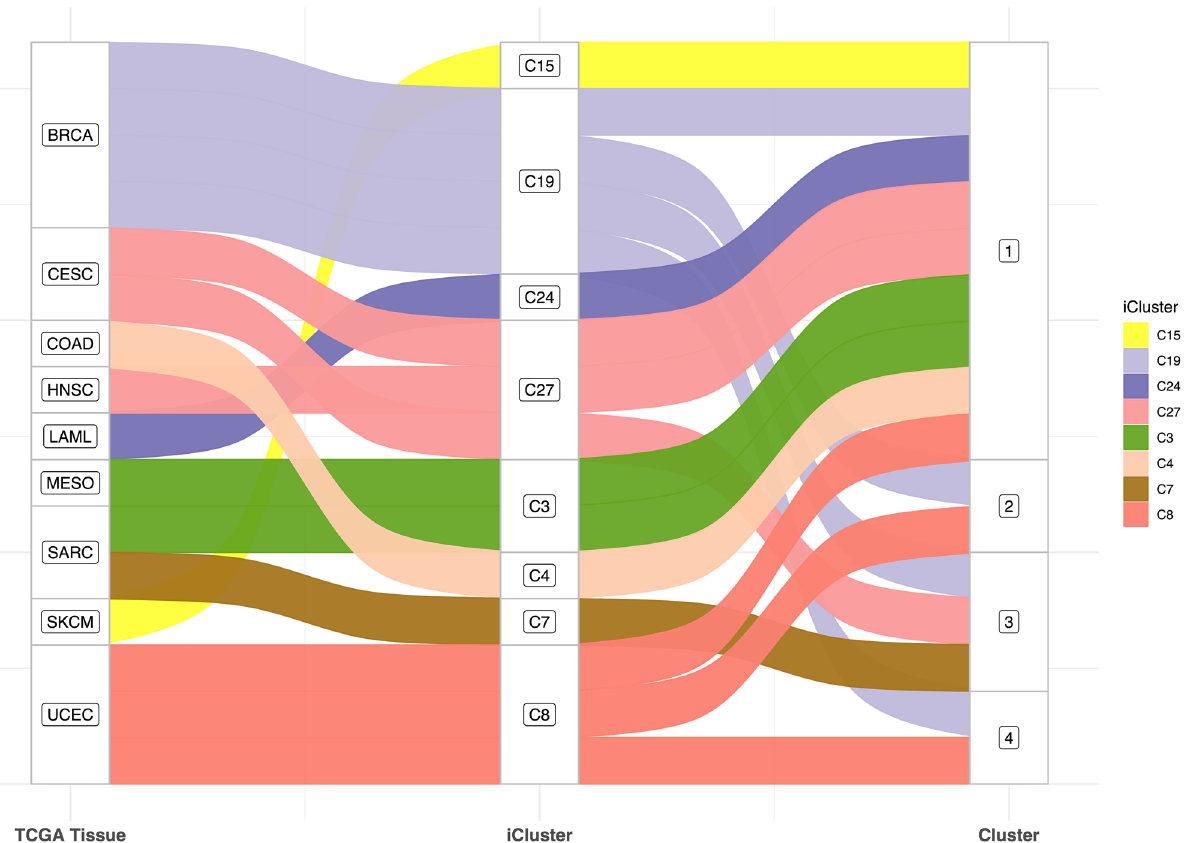
Figure 3. Relationship between TCGA tumor type, iCluster, and response clusters. The Sankey diagram shows the tumor type composition of each iCluster. Cluster designations are shown on the